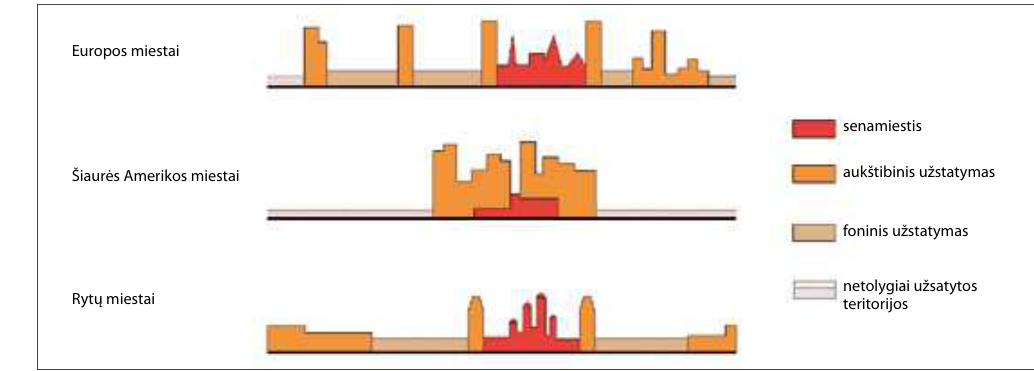
Fig. 11. Development models of high-rise building by heritage conception of particular